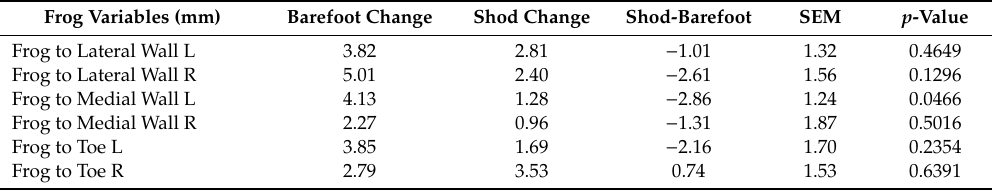
Table 4. Changes in the position of the frog in relation to the sole of the hoof during seven-weeks in horses when they were shod and barefoot. The results are displayed as the mean change when horses were barefoot ( n = 11) and shod ( n = 11), followed by the di ff erence between the two treatments and the standard error of the mean (SEM) di ff erence. Results are displayed for the left (L) and right (R)